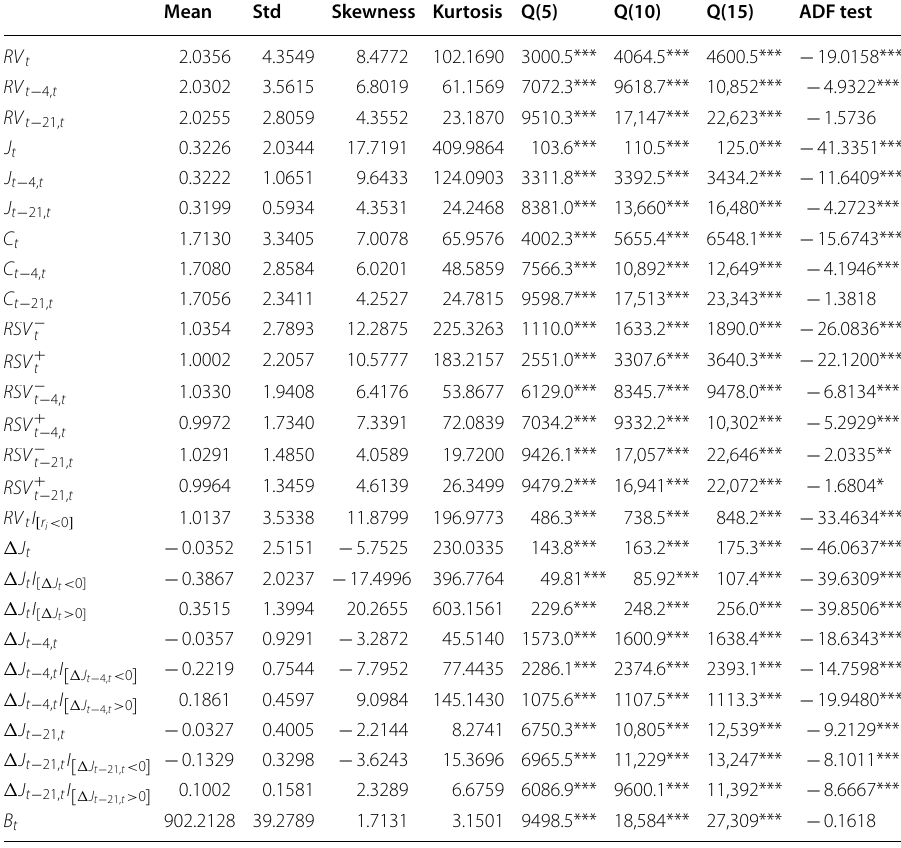
Table 2 Summary statistics for all variables